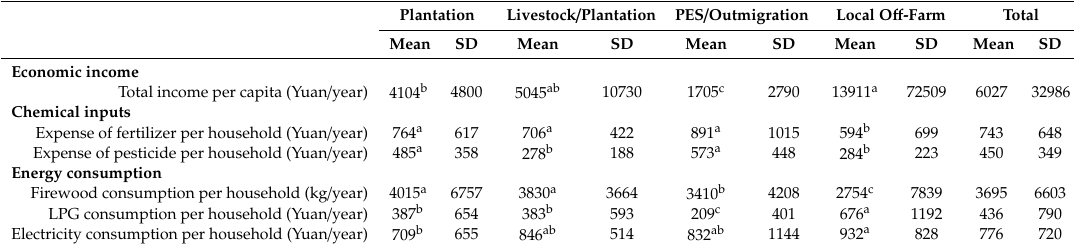
Table 6. Main livelihood outcomes of di ff erent livelihood